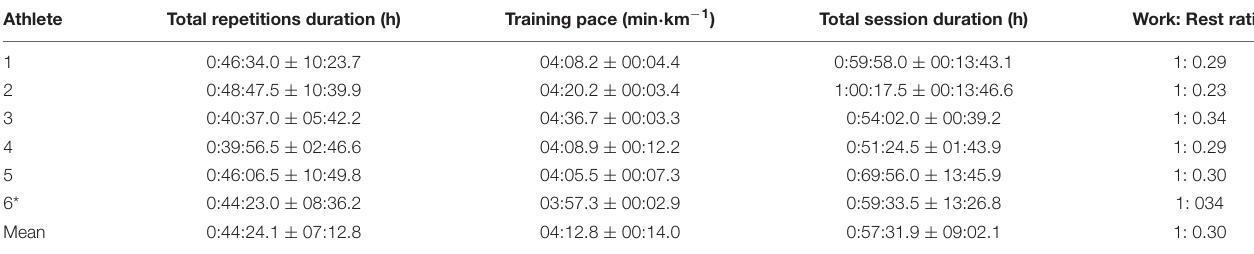
TABLE 4 | Training volume (h) and intensity (min · km − 1 ) of key training sessions (6–8 × 1.2–1.6 km repetitions); 16th July and 23rd July 2021) during the team holding camp. Athlete Total repetitions duration (h) Training pace (min · km − 1 )